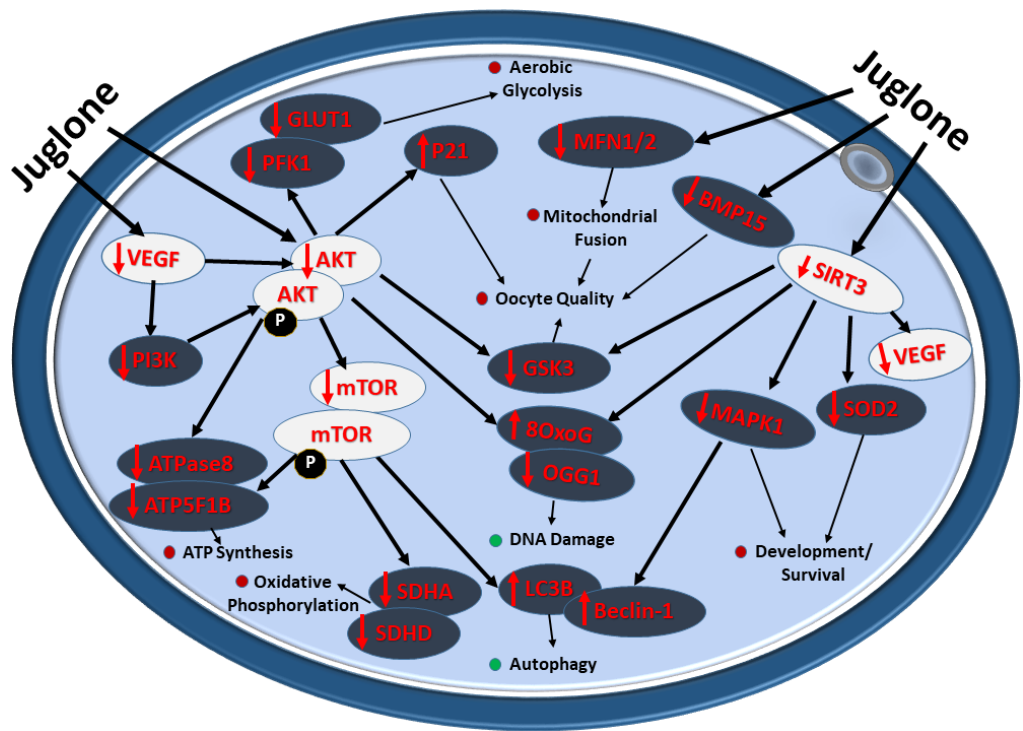
Figure 7. Diagram showing the deleterious impact of juglone implication on bovine oocyte during IVM. Juglone interact with the PI3K/AKT/mTOR signaling and the underlying cascades regulated by this pathway, the effects that negatively retard the development and quality of exposed oocyte. Red and green dots indicate the decrease and increase in the cellular processes affected by juglone in bovine matured oocyte, respectively.